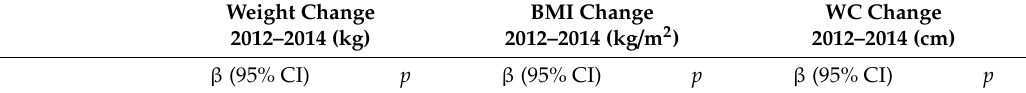
Table 2. Crude and adjusted association between vitamin D intake (2012) and 25(OH)D serum concentration (2014) with the changing variables (weight, body mass index (BMI), and waist circumference (WC)) between 2012 and 2014. EpiFloripa Adults Cohort study, Florian ó polis, Santa Catarina, Brazil. Weight Change BMI 2012–2014 (kg)